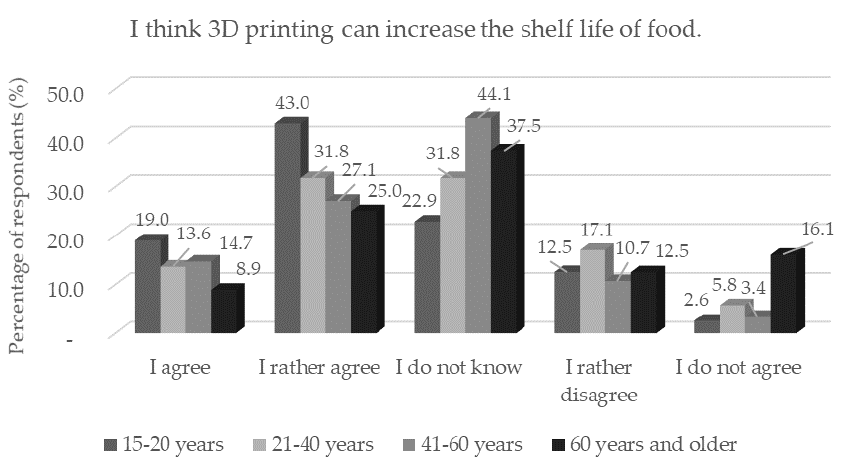
Figure 8. Respondents’ worries and understandings ( n = 1156) by age category in response to the